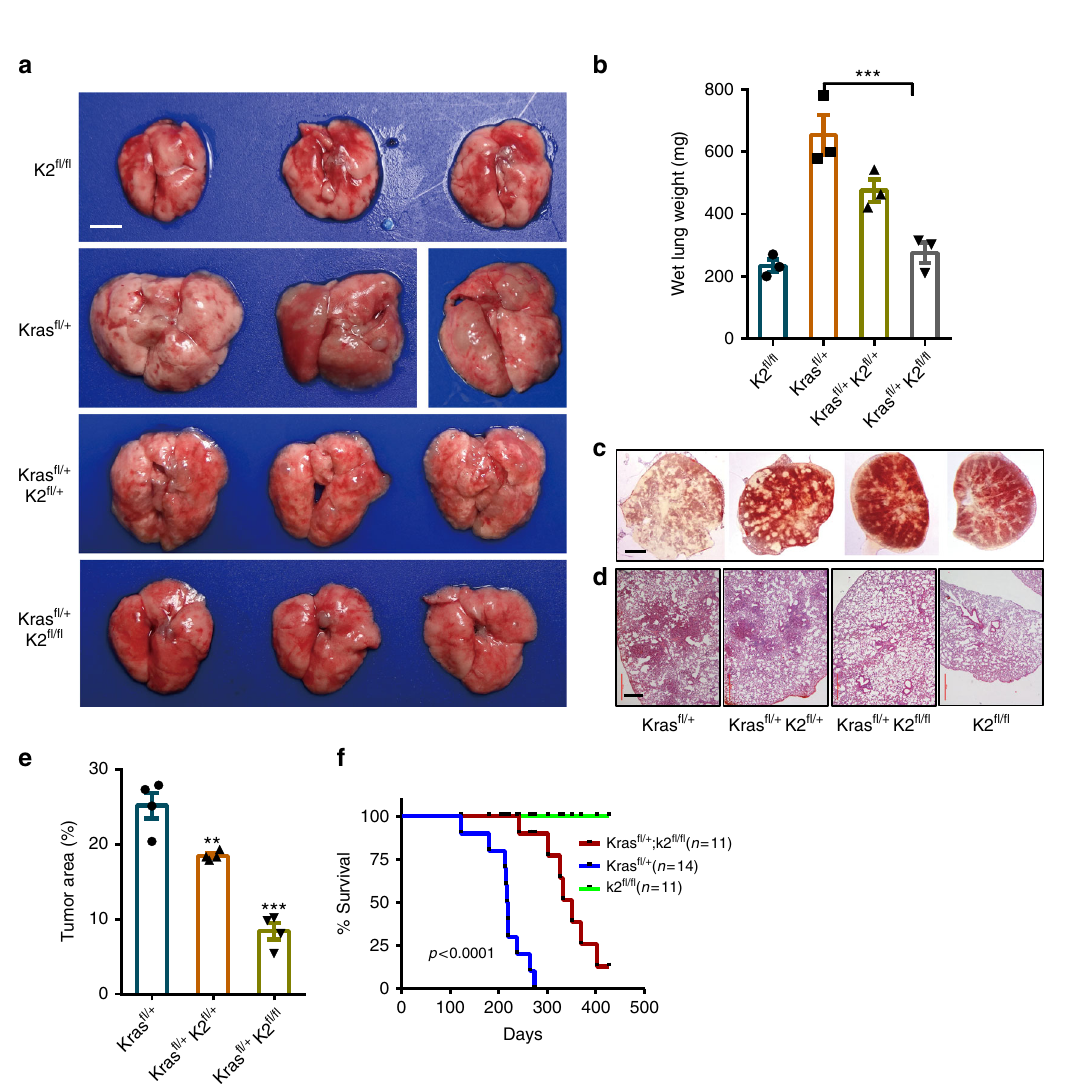
Fig. 9 Ablation of kindlin-2 inhibits Kras G12D -induced lung tumorigenesis and reduces the mortality rate. a – e The lung of the mice (as indicated in the fi gure) was administrated with Ad-Cre and analyzed 16 weeks later. The gloss morphology of the lung was observed ( a ). Scale bar = 1 cm. The lung tissues from the mice were weighed ( b , 3 mice for each group). The lung was pressed onto two slides and observed under microscopy for analyses of lung tumors ( c ). Scale bar = 0.5 cm. Sections of the lung tissues from the mice were analyzed by HE staining ( d ). Scale bar = 200 μ m. Tumor area was quanti fi ed as described in the Methods ( e , 4 mice for each group). f Kaplan – Meier survival curve of Kras LSL − G12D/ + (Kras fl / + ) mice ( n = 14) vs. Kras LSL − G12D/ + ; kindlin- 2 fl / fl (Kras fl / + ; K2 fl / fl ) mice ( n = 11) for up to 428 days post-administration of Ad-Cre. Data in b and e present mean ± SEM ( n = 3) using one-way ANOVA with Tukey – Kramer post-hoc analysis, ** P < 0.01; *** p < 0.001. Kaplan – Meir survival analysis in f was determined by log-rank test